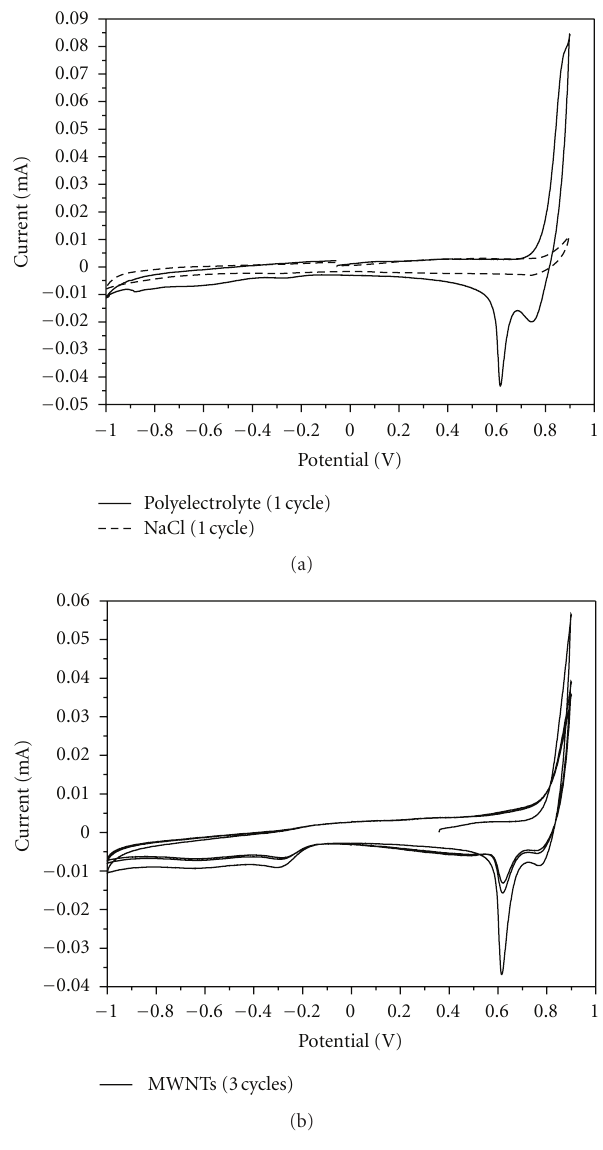
Figure 4: Voltamperograms corresponding to (a) bare electrolyte and polyelectrolyte, as well as (b) functionalized nanotubes with the polyelectrolyte versus